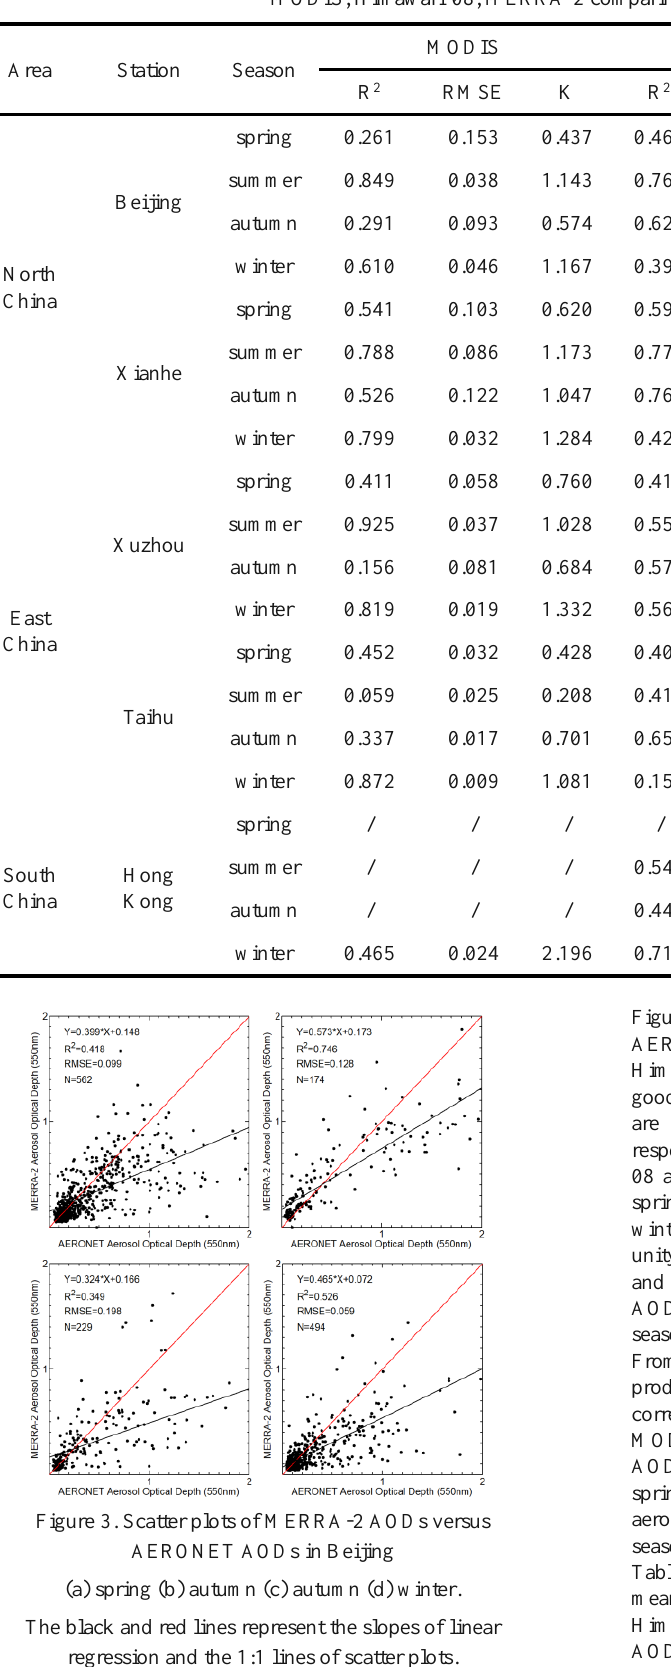
Table 2. The squared correlation coefficients (R 2 ), the root mean square errors (RMSE) and the slopes (K) of regression lines of MODIS, Himawari-08, MERRA-2 comparing with AERONET AODs Area Station